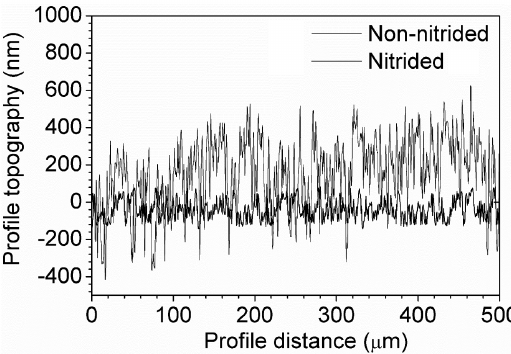
Figure 2. 2D topography profile results of the non-nitrided and nitrided niobium surface.